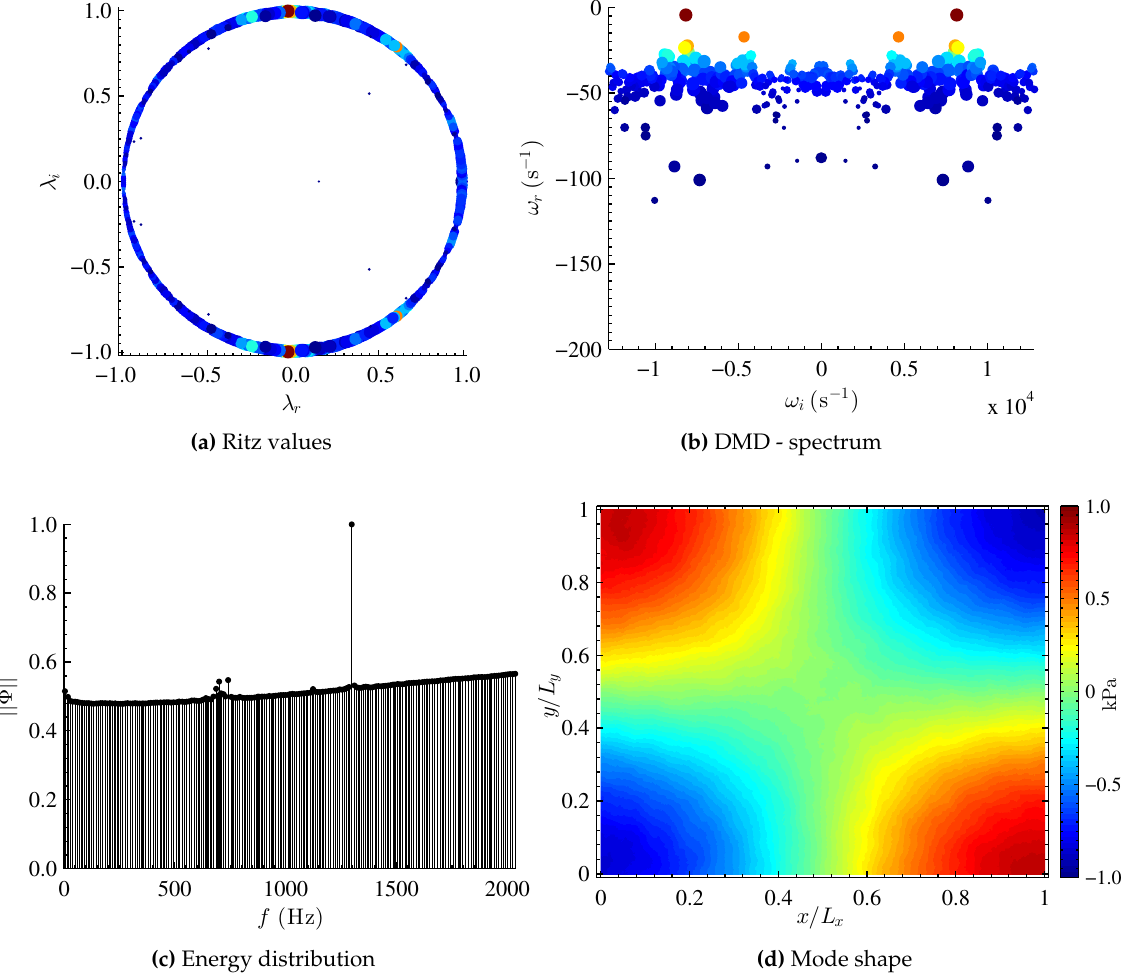
Figure 5. Dynamic mode decomposition (DMD) results for mode shape ( 1,1,0 )